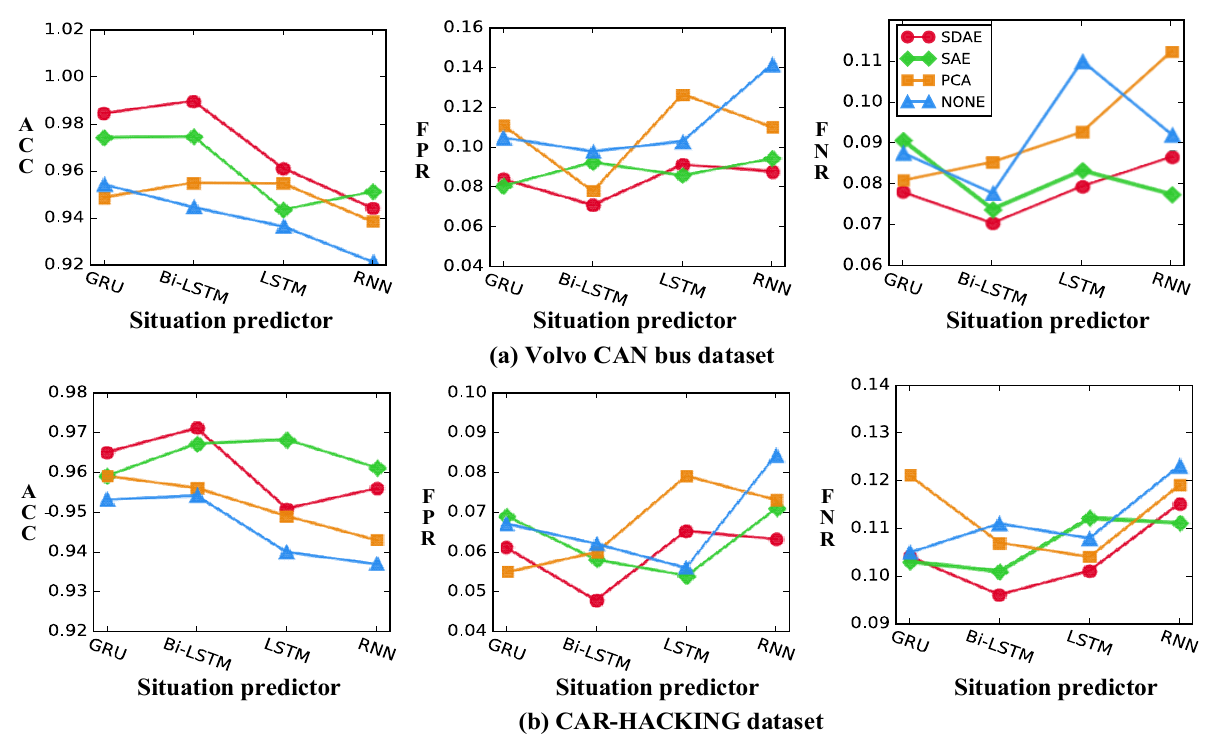
Figure 7. Performance analysis of SDAE on two datasets. ( a ) the performance comparison of four features extractors on Volvo CAN bus dataset; ( b ) the performance comparison of four features extractors on CAR-HACKING dataset.